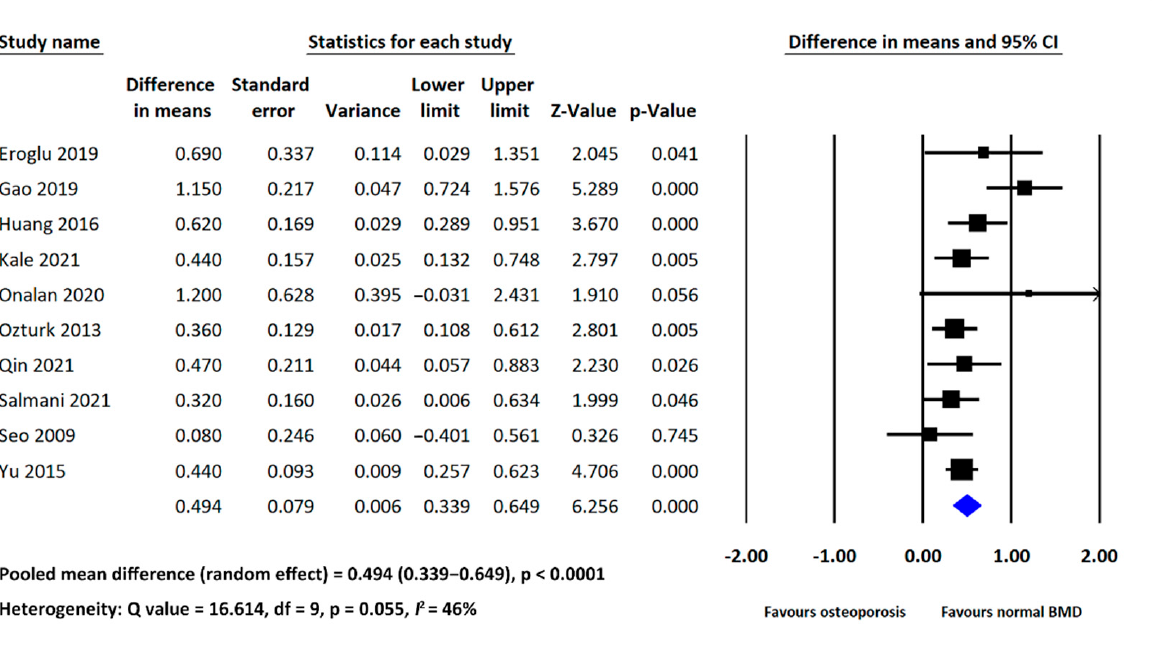
Figure 2. Forest plot of the mean difference in NLR between the osteoporosis and normal BMD groups [17–26].